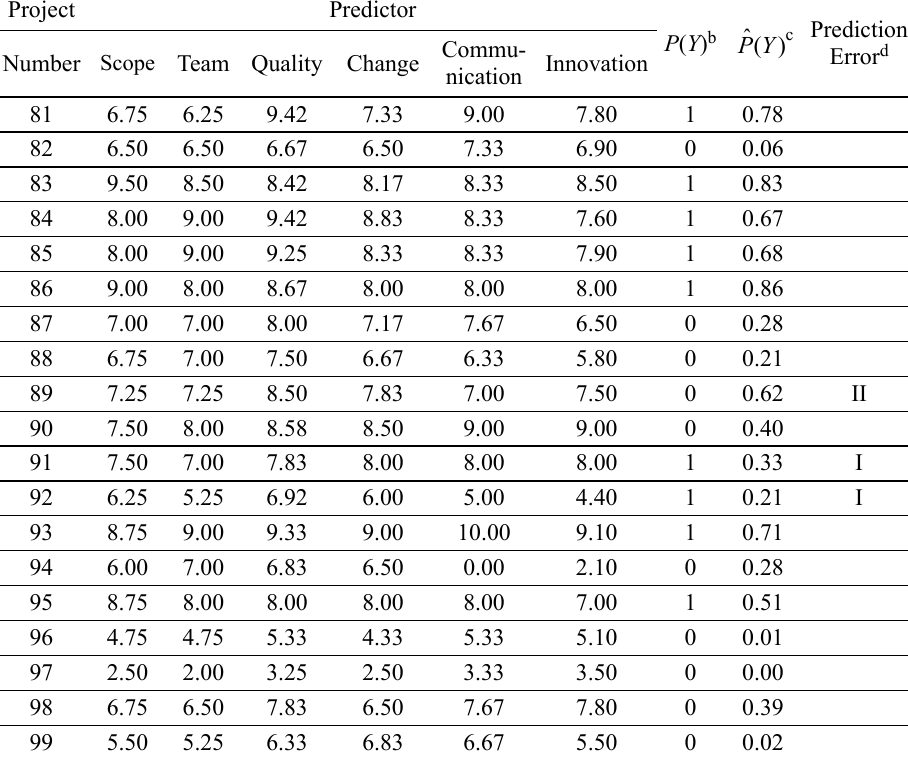
Table 6. Out-of-sample forecasts by project-outcome prediction model (Model 6 a ) Project Predictor